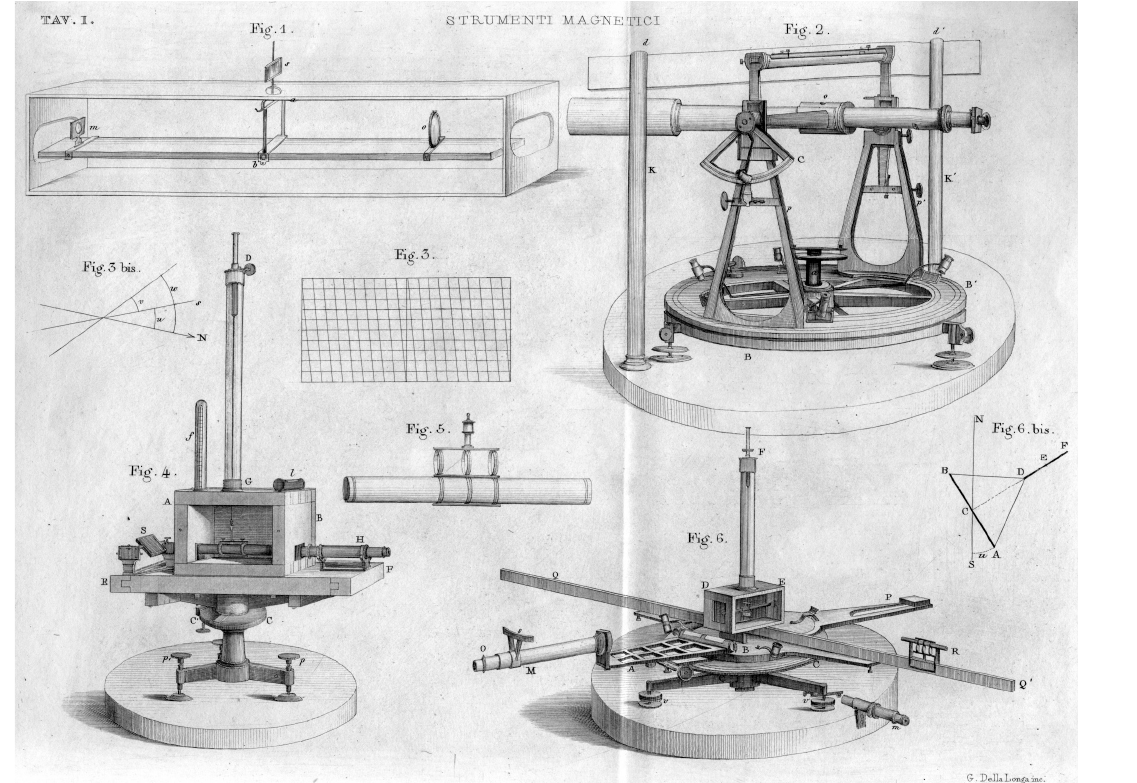
Figure 6. Plate I (“Tav. I”) showing the instruments installed in the Collegio Romano Magnetic Observatory (Secchi, 1861).